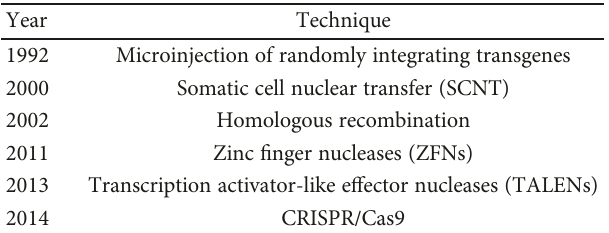
Table 1: Timeline for application of evolving techniques for genetic engineering of pigs employed in